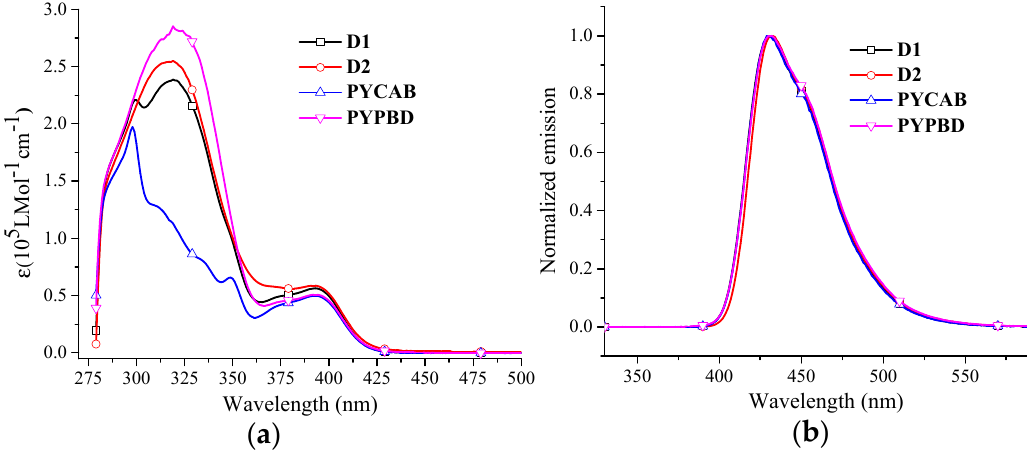
Figure 2. UV-vis absorption ( a ) and PL spectra of dendrimers ( b ), excited at 299 nm for PYCAB , 319 nm for the others (10 − 5 M, toluene).